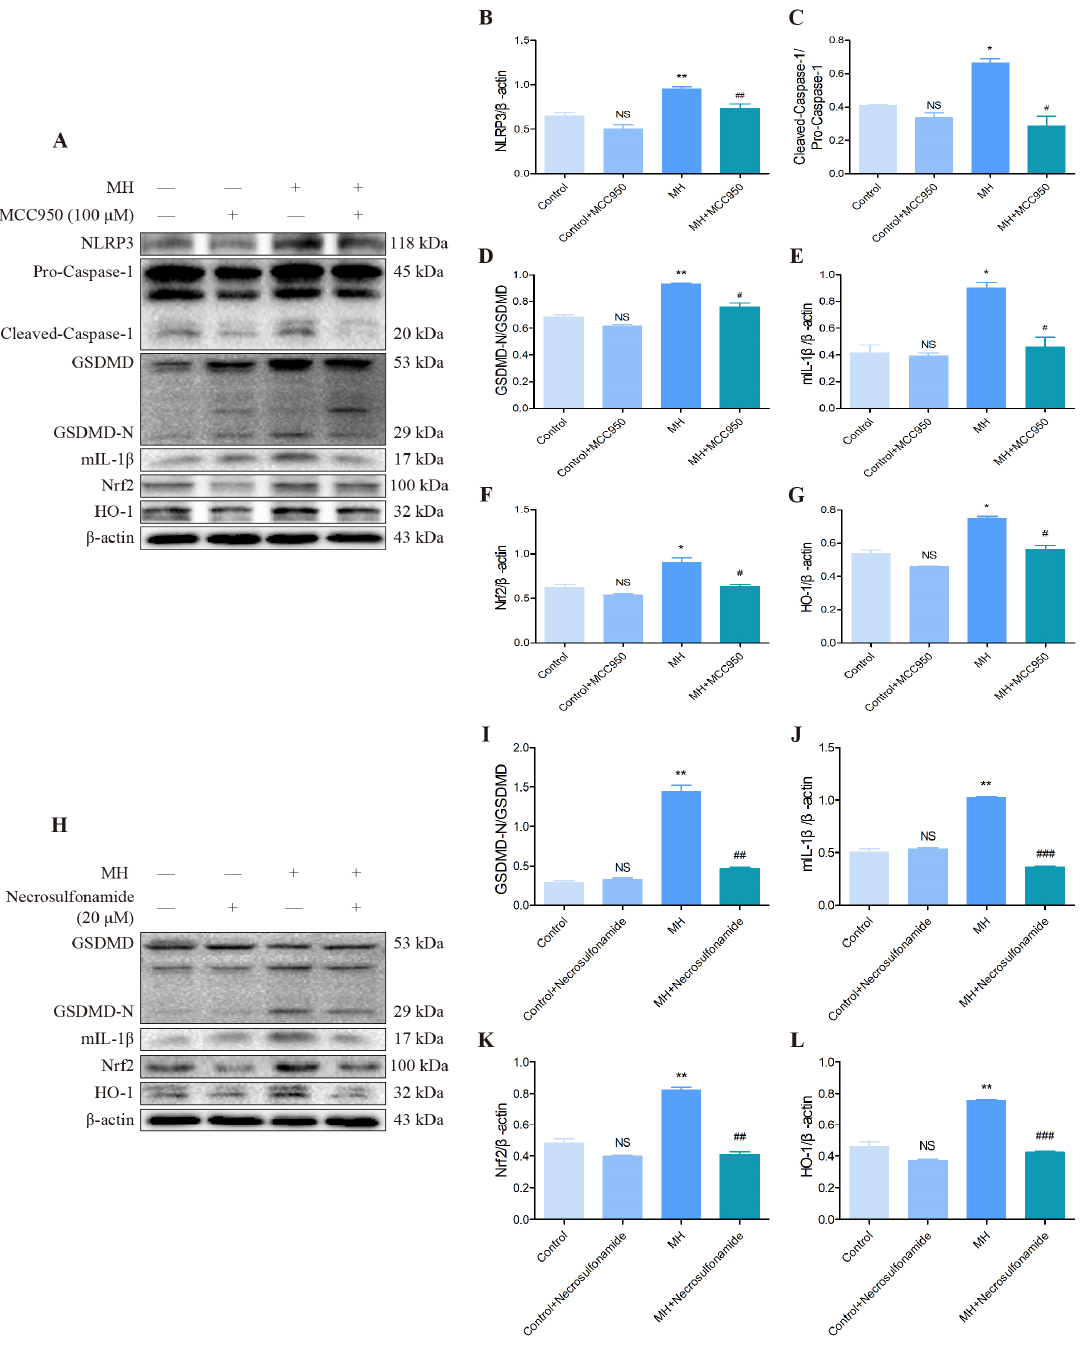
Figure 8. The relevant signaling pathway expression of pyroptosis of key proteins in AML12 cells after adding NLRP3 or GSDMD inhibitor treatment for 3 h as assessed by Western blotting and relative density analyses. ( A ) The protein level of NLRP3, Caspase-1, GSDMD, IL-1 β , Nrf2, HO-1 and β -actin in each group after adding NLRP3 inhibitor (MCC950). ( B – G ) Analysis of the protein expression by the ratio of NLRP3/ β -actin, Cleaved-Caspase-1/Pro-Caspase-1, GSDMD-N/GSDMD, mIL-1 β / β -actin, Nrf2/ β -actin, HO-1/ β -actin. ( H ) The protein level of GSDMD, IL-1 β , Nrf2, HO-1 and β -actin in each group after adding GSDMD inhibitor (necrosulfonamide). ( I – L ) Analysis of the protein expression by the ratio of GSDMD-N/GSDMD, mIL-1 β / β -actin, Nrf2/ β -actin and HO-1/ β - actin. Data are presented as mean ± standard ( n = 3). NS means not significant, * p < 0.05, ** p < 0.01, # p < 0.05, ## p < 0.01, ### p < 0.001. Where * represents comparison with the control group, and # represents comparison with the MH